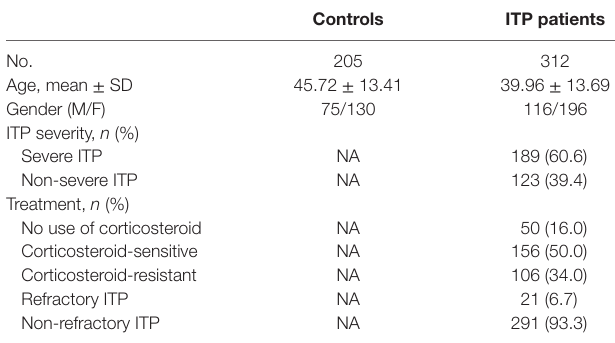
TaBle 1 | Selected genes and SNPs. genes